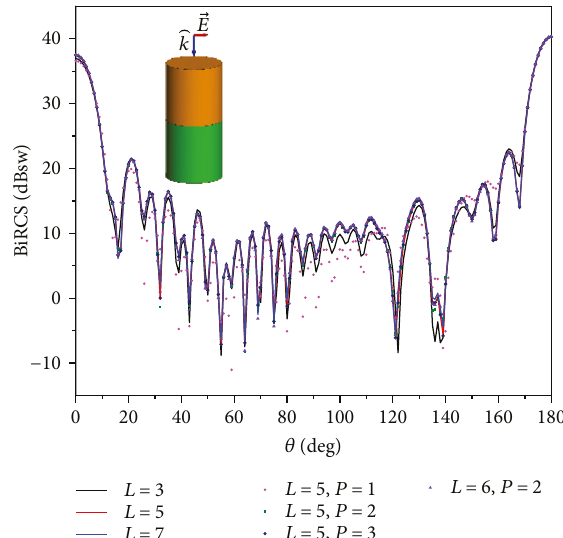
Figure 1: BiRCS of a conductor-dielectric cylinder by using conventional MLFMA and proposed method with di ff erent P and L .